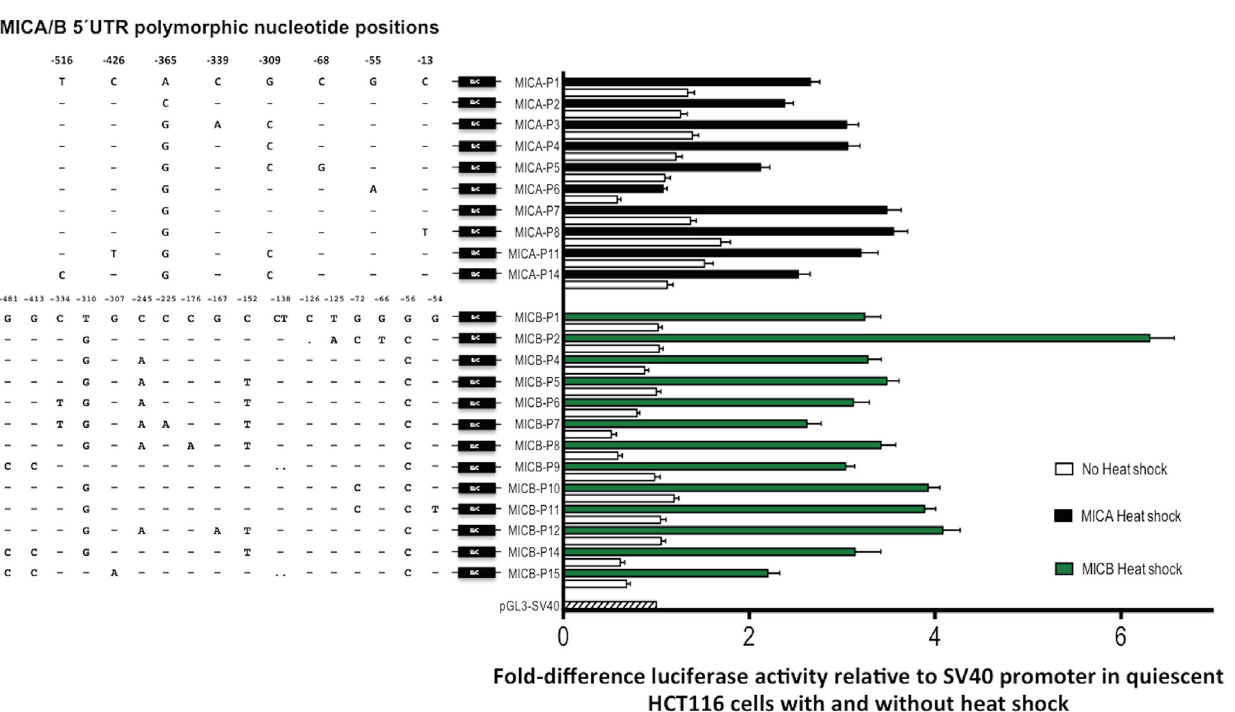
FigUre 8 | Transcriptional analysis of MHC class I-related chain A (MICA) and MHC class I-related chain B (MICB) promoter regions. 5 ′ UTR polymorphic nucleotides associated with each type of MICA/B promoter are shown on the left and fold transcriptional activity relative to SV40 promoter is shown alongside. Quiescent HCT116 cells were grown to over-confluence for 7-day post-transfection before being heat-shock-treated (black/green bars) or isotype-treated without heat-shock (white bars). Fold-difference relative to SV40 control plasmid transfection is indicated. Assay conditions were performed in triplicate with three independent preparations of plasmid construct DNA and repeated for a total of four independent experiments. Nucleotide positions relative to ATG start codon are indicated for each polymorphic position. Abbreviations: UTR, untranslated region; LUC, luciferase